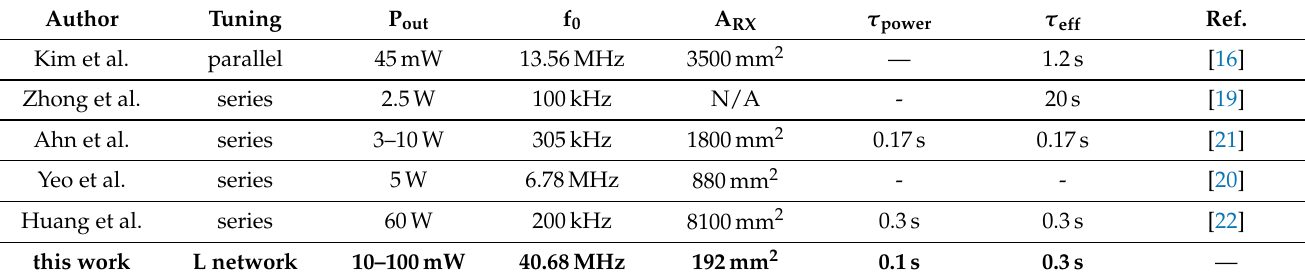
Figure 17. Main characteristics of different maximum efficiency point tracking systems reported in the literature: typical output power level P out , receiver circuit footprint A RX and typical time to reestablish the maximum efficiency τ eff . For all metrics, smaller values are better to accomplish the objectives of low-power biomedical sensor systems. Table 5. Main characteristics of maximum efficiency point tracking systems reported in the